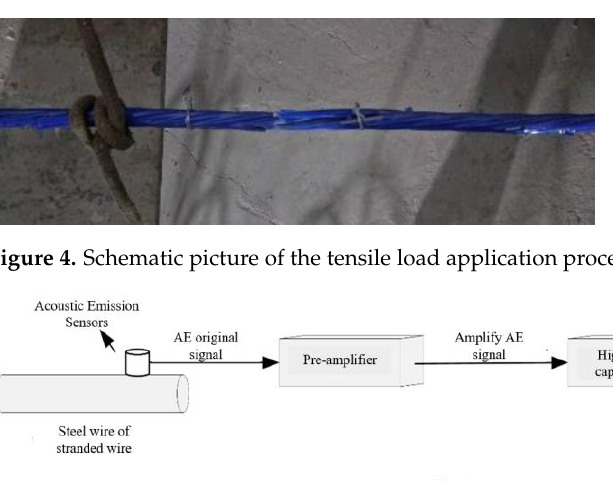
Figure 3. Acoustic emission sensors.